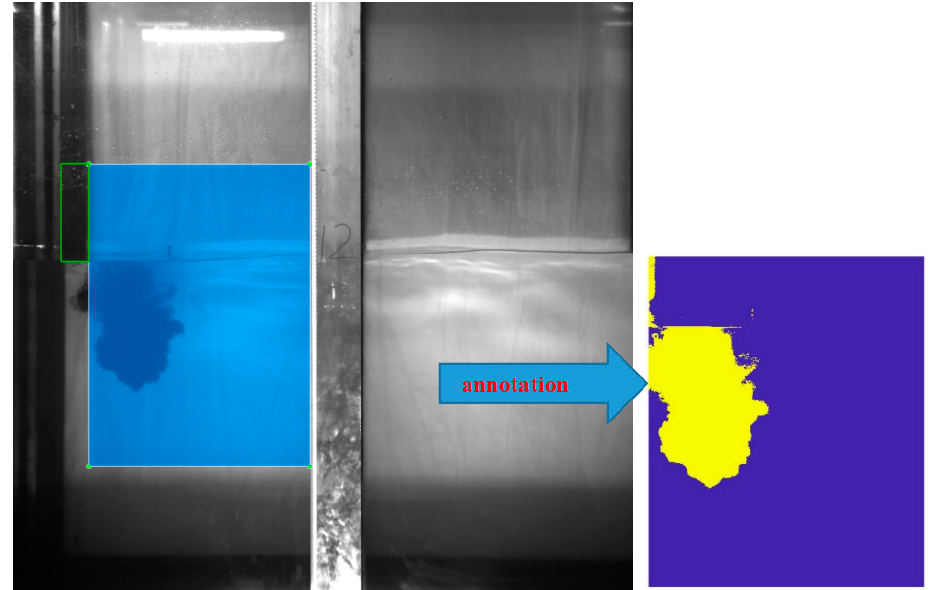
Figure 3. Sunken and submerged oil in the observation